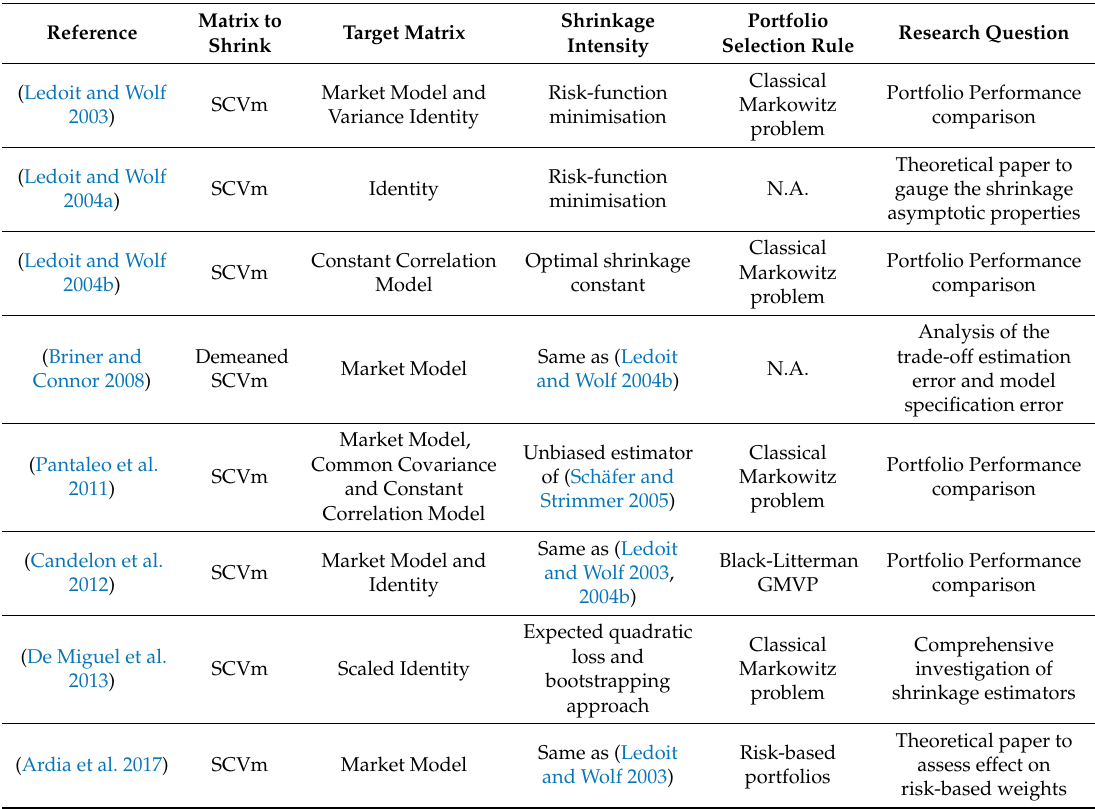
Table 1. Literature review of target matrices. “SCVm” = sample covariance matrix. “N.A.” = not available. “GMVP” = Global Minimum Variance